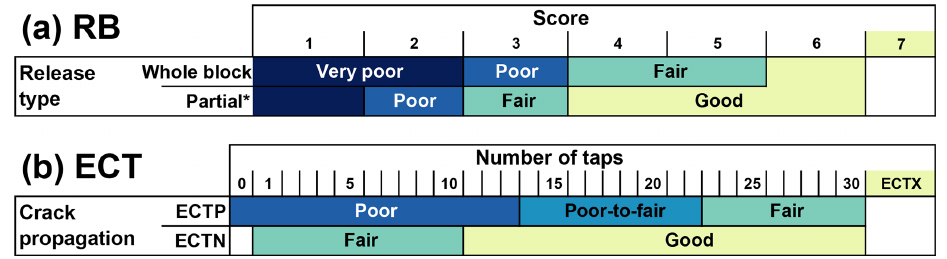
Figure 1. Stability classification of (a) rutschblock test results (based on Schweizer, 2007a; Techel and Pielmeier, 2014) and (b) extended column test results (based on Techel et al., 2020). ∗ Partial includes release types most of block and edge